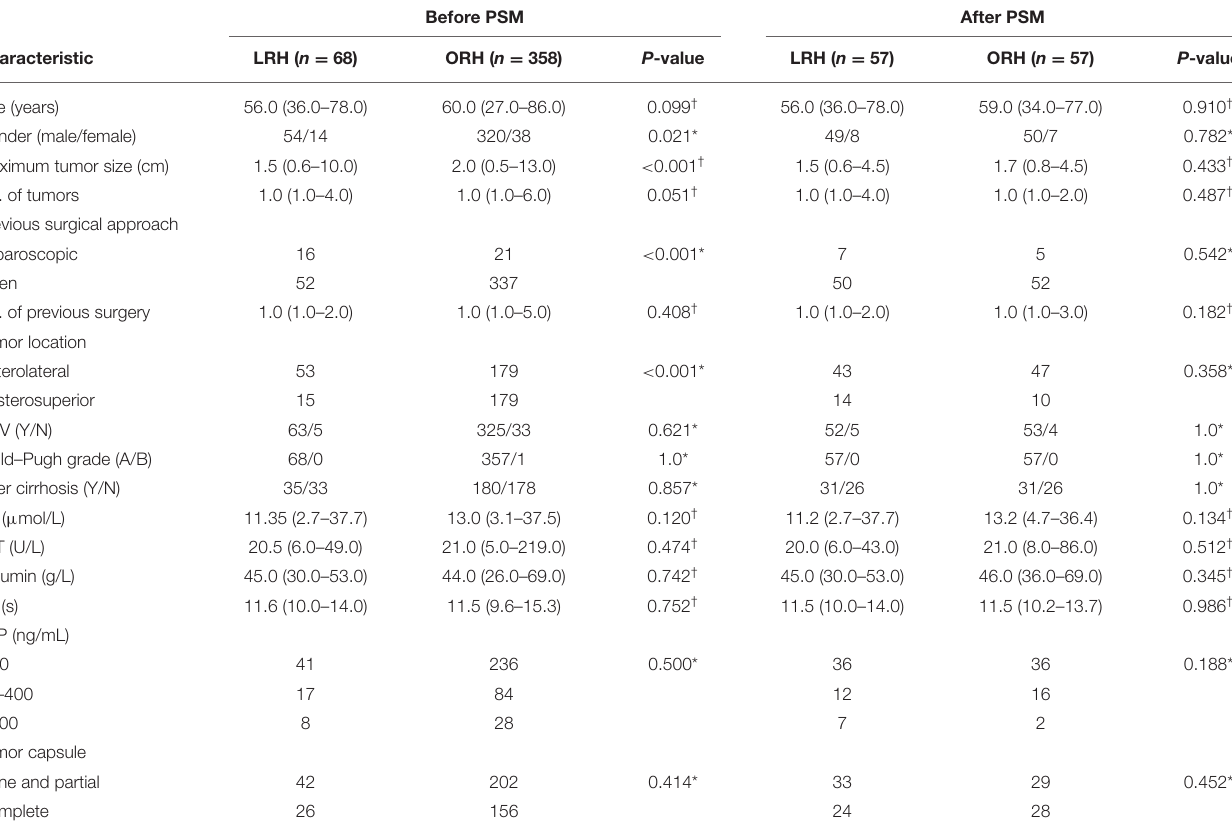
TABLE 1 | Patient baseline characteristics and tumor characteristic.